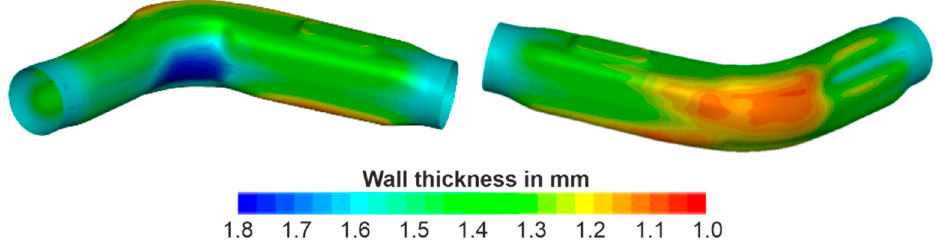
Figure 3. Numerically determined wall thickness distribution.